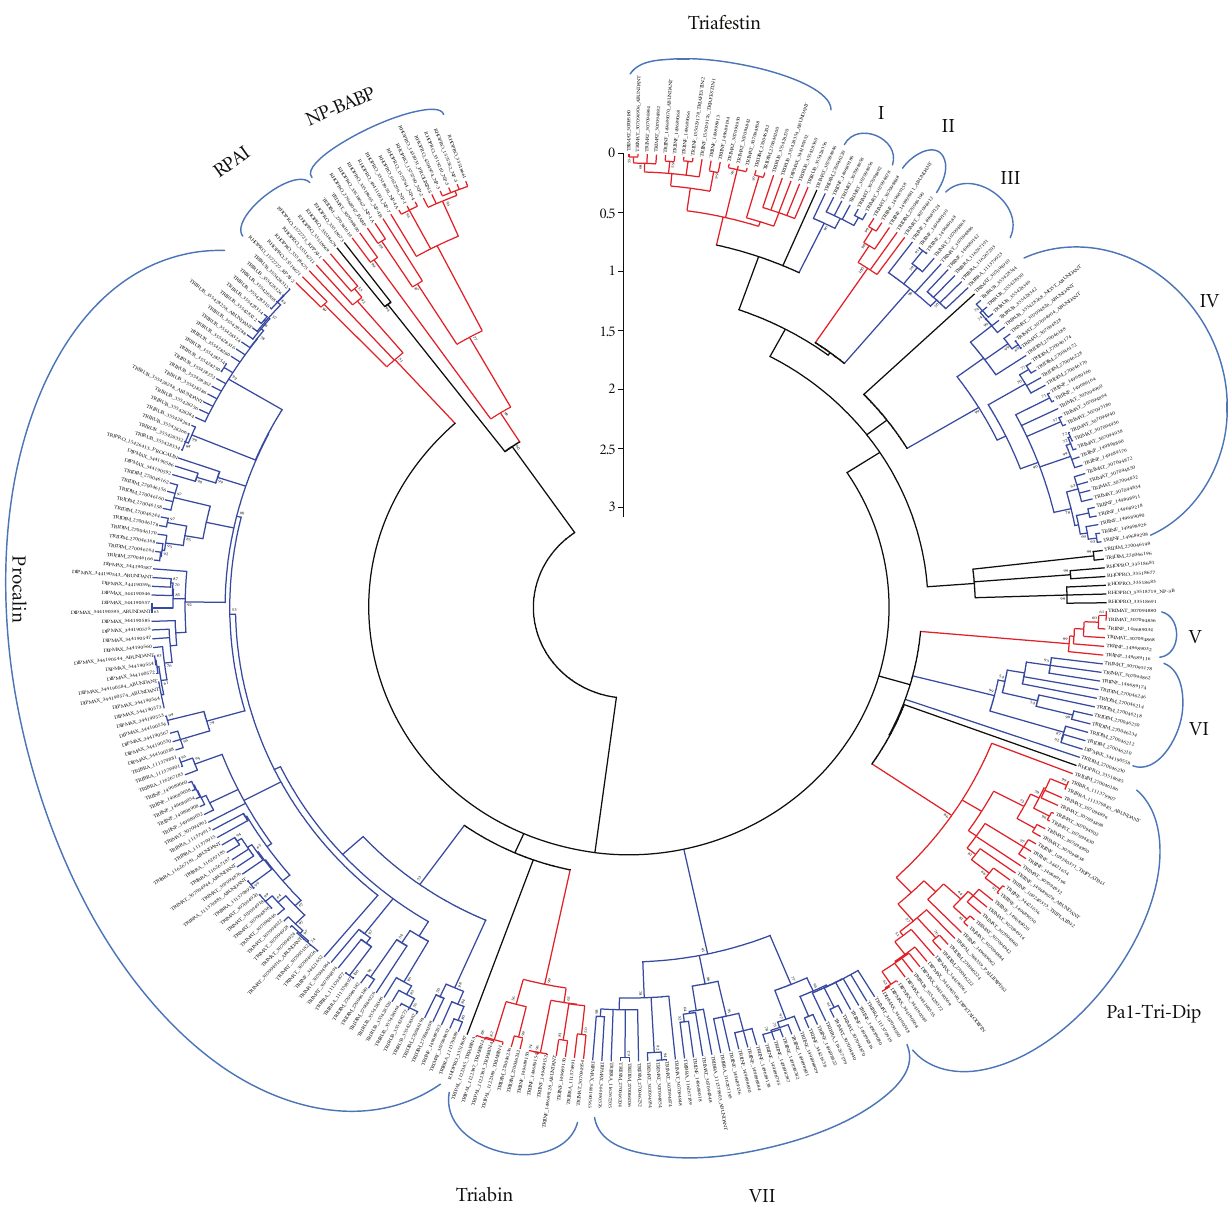
Figure 3: Phylogram of the salivary lipocalin family of triatomines. Clades containing members that have been functionally characterized are named according to these proteins. Other clades are named with Roman numerals. Except for the triafestin clade, other clades have > 70% bootstrap support. The sequences are named with the first 3 letters of the genus name, followed by the first 3 letters of the species name, followed by their GenBank gi | accession number. When the protein has been functionally characterized, its name is also included after the NCBI number. Abundantly expressed proteins are also marked to indicate this fact. The numbers in the bar indicate the rate of amino acid substitution per site. For other details, see Figure 1